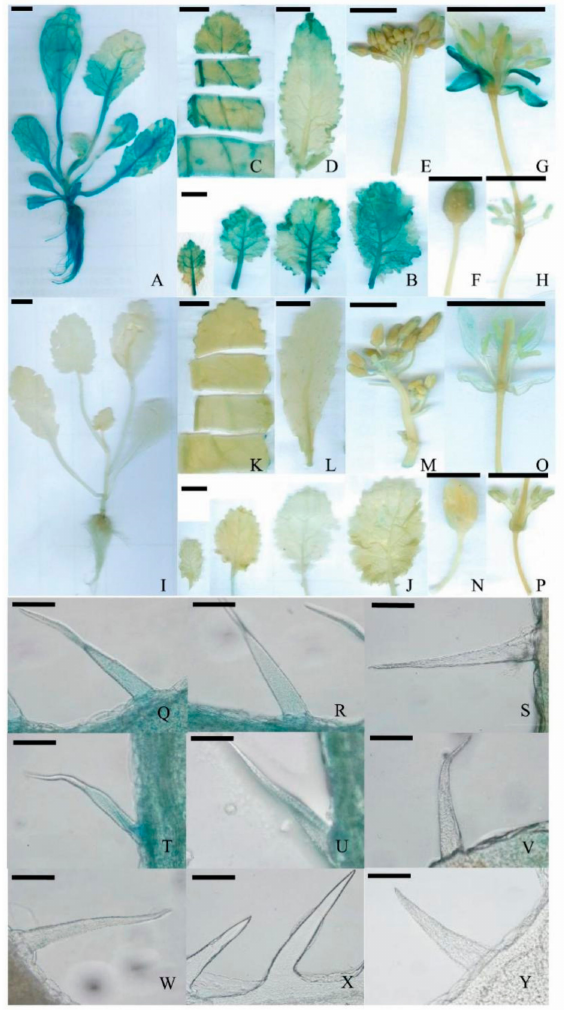
Figure 2. Histochemical β -glucuronidase (GUS) staining in tissues of Pro BraLTP2 ::GUS